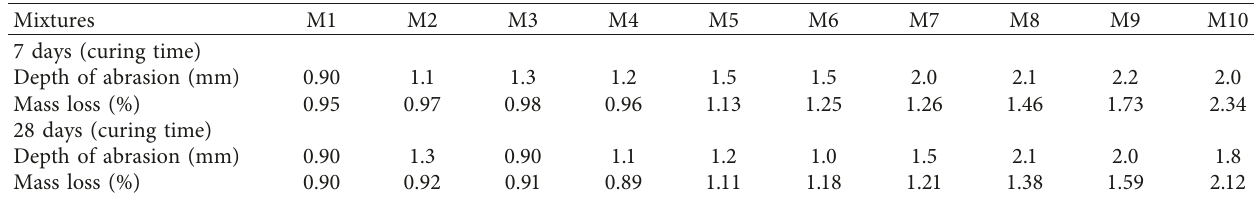
Table 6: Abrasion depths and mass losses of SCC series.